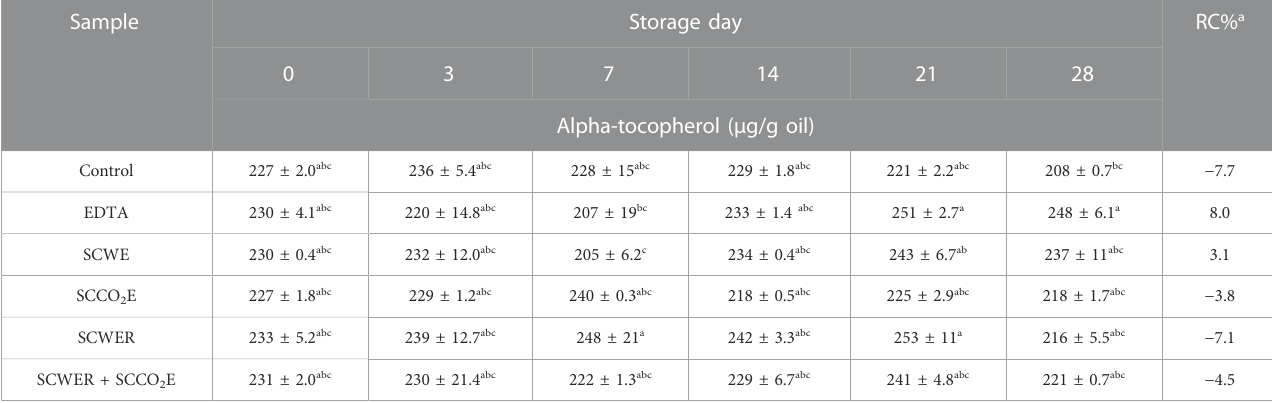
TABLE5Alpha-tocopherolcontentofthedifferentmayonnaiseduringdifferentstoragedays(day0 – 28),includingtherelativetocopherolconsumptionduringstorage